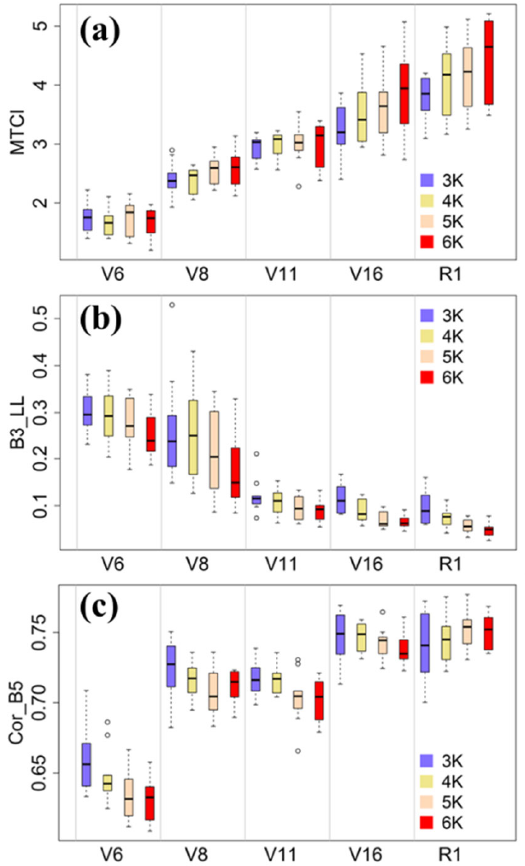
Figure 14. Distribution of MTCI, B3_LL, and Cor_B5 along with the growth stage and planting density. ( a – c ) represent LCD, LAI and CCD respectively.